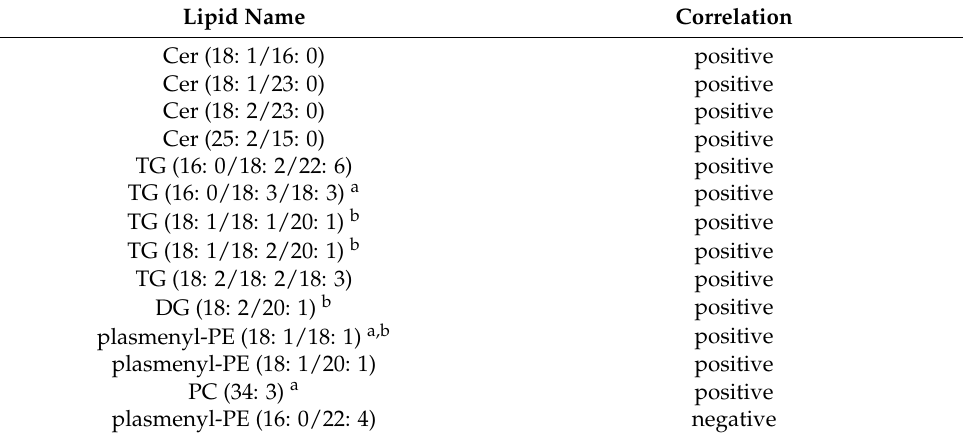
Table 5. The significantly changed correlating with C3 → A1 → D4 → B2 pattern, based on Spearman correlation coefficients >0.5; B2, mycotoxin-exposed NAFLD group; C3, silymarin-treated NAFLD group; D4, mycotoxin plus silymarin-exposed NAFLD group; A1, control NAFLD group. Lipid Name